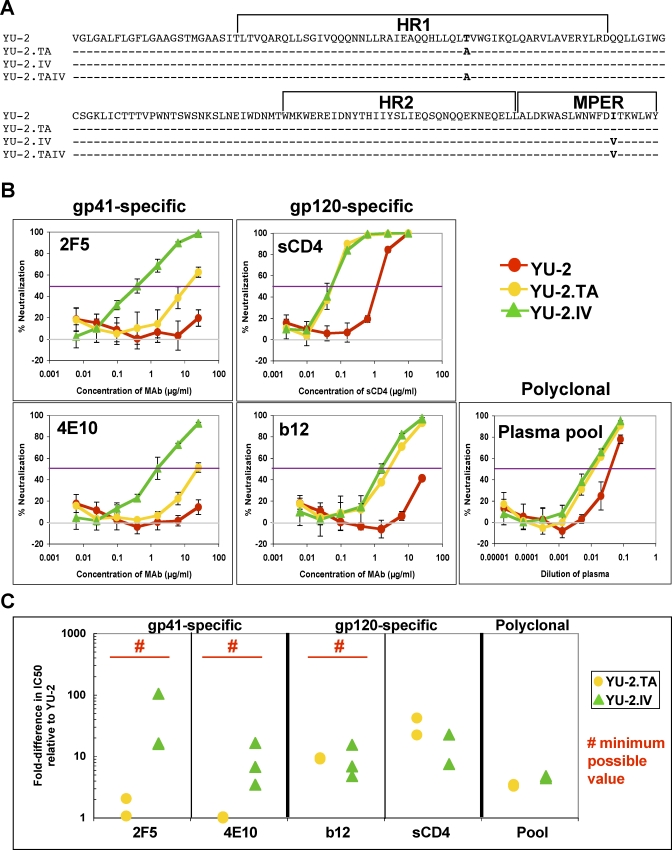
Sequence and Neutralization Profiles of the Subtype B YU-2 Envelope Variants(A) The predicted gp41 amino acid sequences of YU-2 and the TA, IV, and TAIV mutants. Layout is as described in the legend to Figure 1A.(B) Neutralization curves of pseudotyped viruses made with the Env variants described in (A) are shown. The layout is as described in the legend to Figure 1B.(C) The fold-difference in the IC50 for the YU-2 mutants relative to YU-2 is shown on a log scale as in Figure 1C.